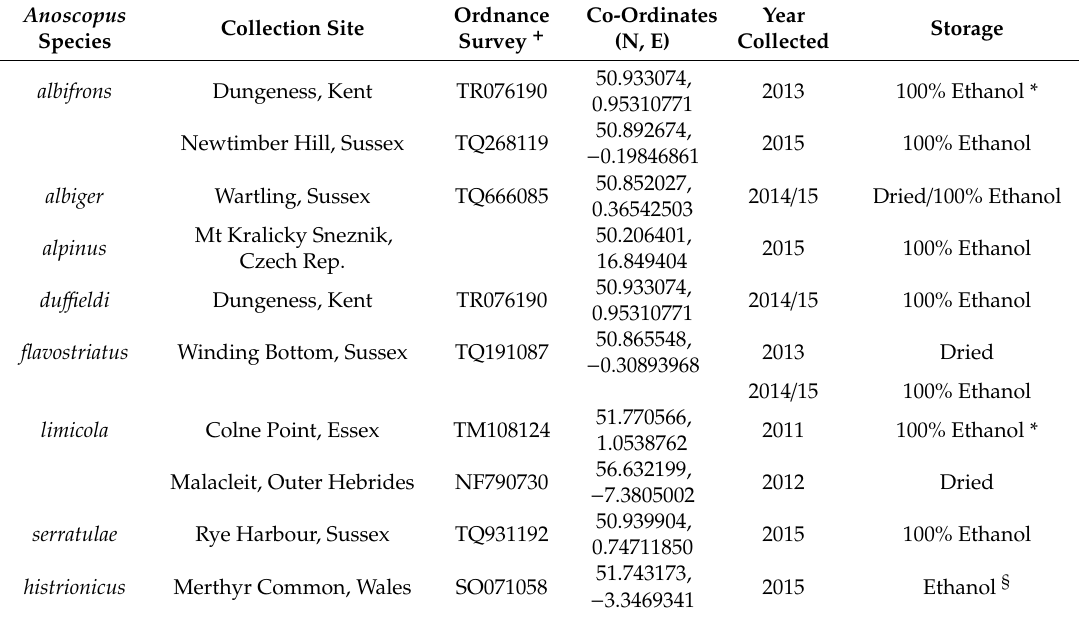
Table 1. Collection site, year and storage method for the Anoscopus specimens